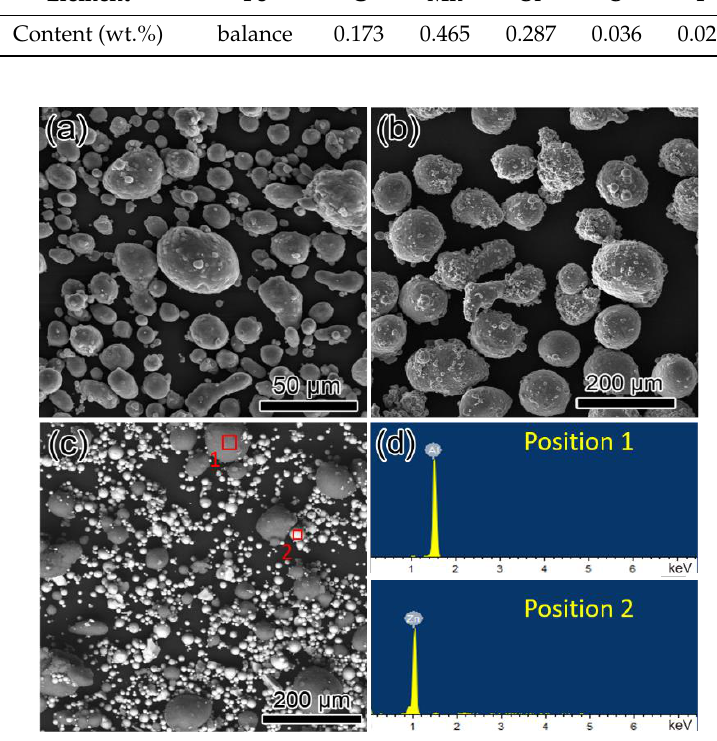
Figure 1. The Scanning Electron Microscopy (SEM) images of the as-received powders: ( a ) Zn powders; ( b ) Al powders; ( c ) Zn-Al mechanically mixed Zn–Al powders and ( d ) the EDX results of the region marked in ( c ). Table 1. Composition of the mild steel.